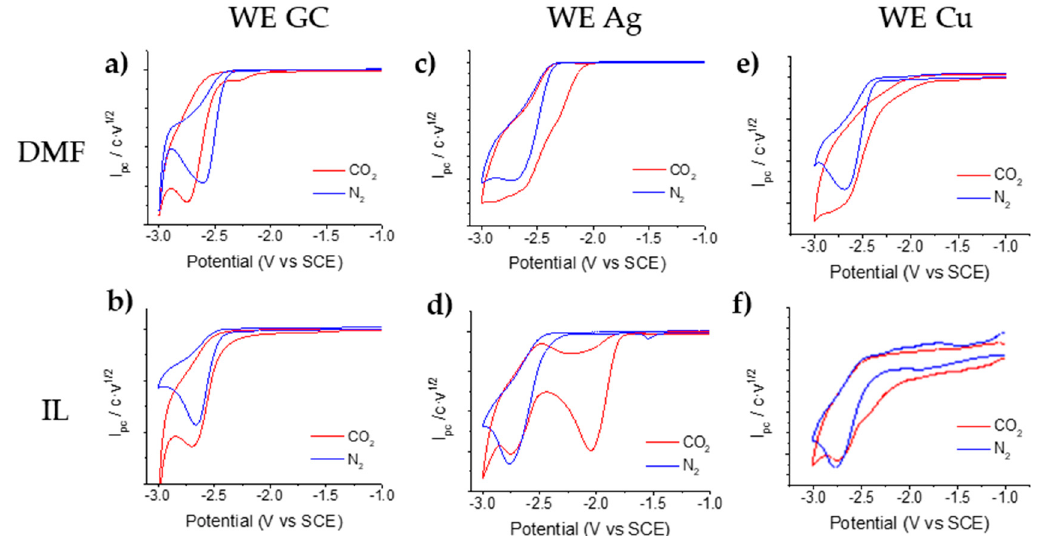
Figure 5. Cyclic voltammetry of solutions of 10–25 mM of 1 and 0.1–0.4M [CO 2 ] in DMF/0.1M TBA PF 6 using as WE ( a ) GC, ( c ) Ag and ( e ) Cu. Cyclic voltammograms in BMPyr TFSI with WE ( b ) GC, ( d ) Ag and ( f ) Cu. Scan rate: 0.5 V·s − 1 .